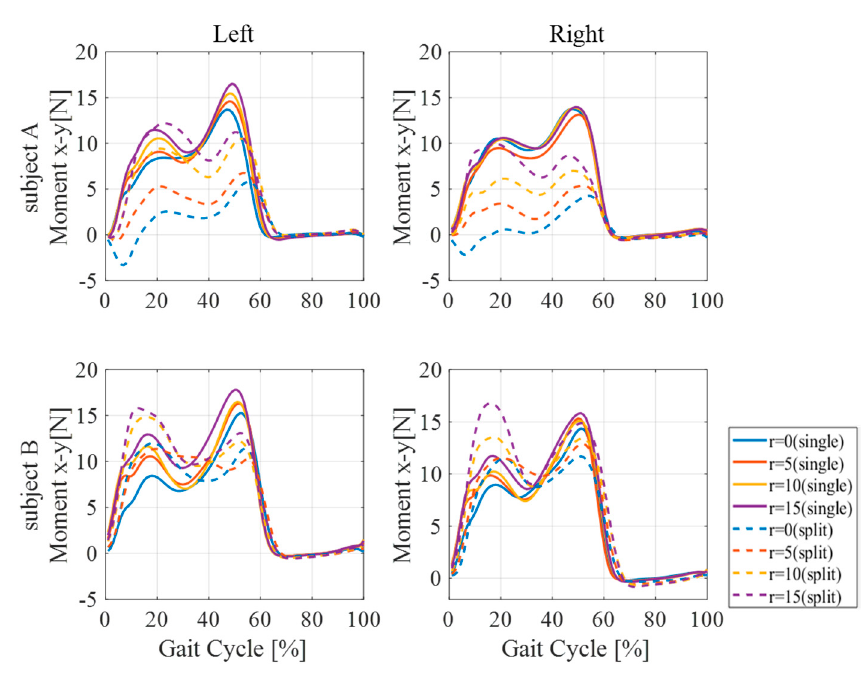
Figure 3. Ankle joint moment of single-belt and split-belt